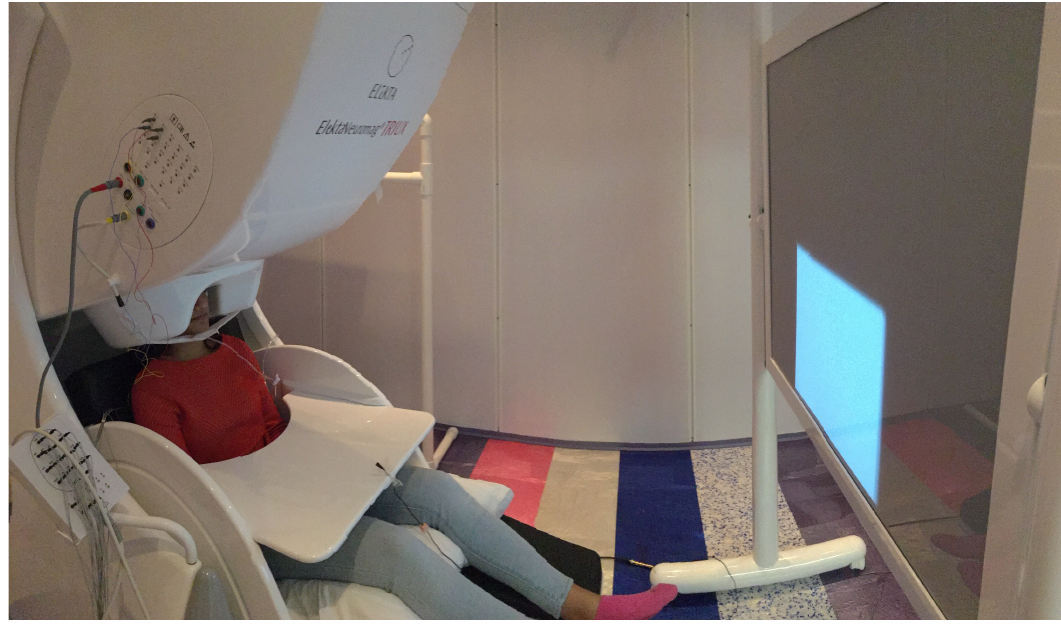
Figure 1. The MEG